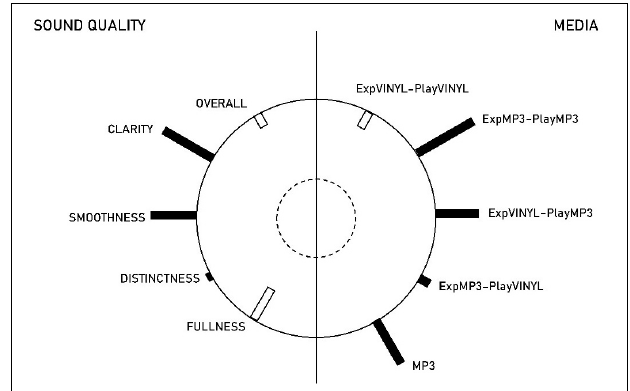
TABLE 1 | Canonical solution for sound quality and experimental conditions.